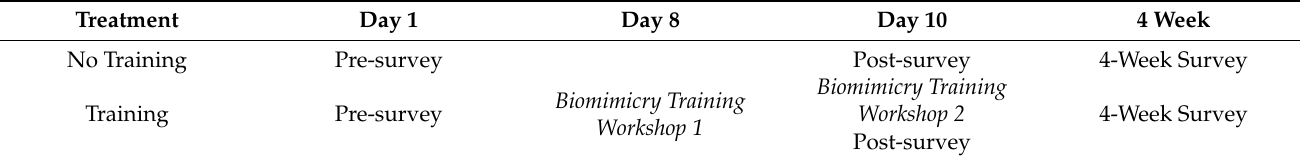
Table 1. Study design. This was repeated for each SBA, one per month from November to Febru- ary. The pre-survey was identical for both treatment groups focused on “sustainable engagement opportunities”. The post-survey and 4-week survey for the no-training group remained unchanged. The post-survey and 4-week survey for the training group contained the same survey questions with slightly adapted terminology to focus on the effect of the “biomimicry training” (Appendix